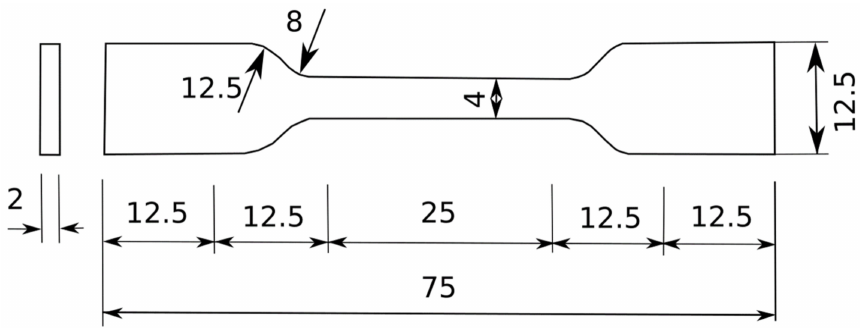
Figure 8. Standardized adhesive specimen for the uniaxial tensile test according to ISO37: